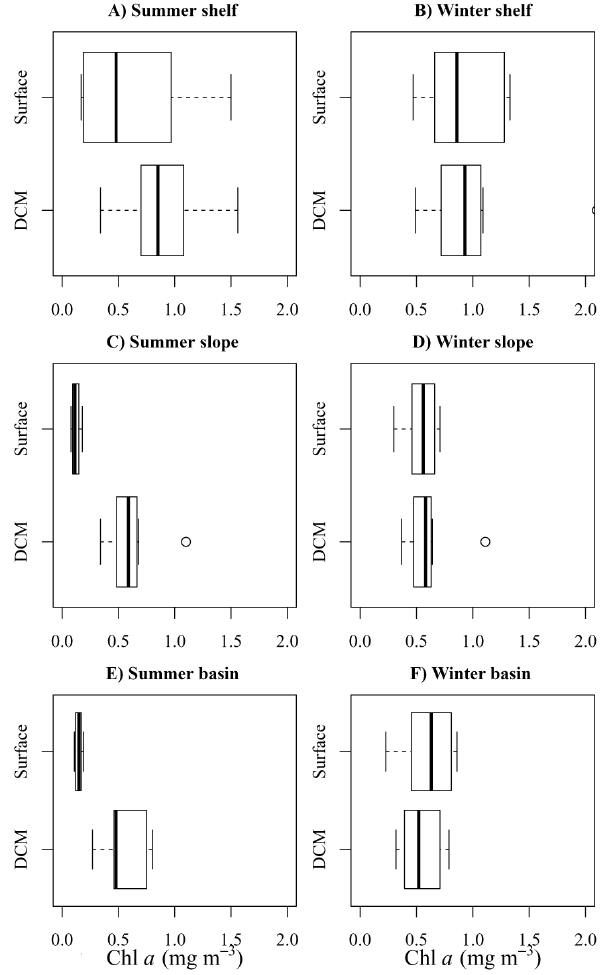
Fig. 2. Box plots of Chl a (mgm − 3 ) in surface and DCM waters. The line through the middle of the box shows the median. The outer edges of the box correspond to the 25th and 75th percentiles, and the “whiskers” to the 10th and 90th percentiles. The dots represent extreme